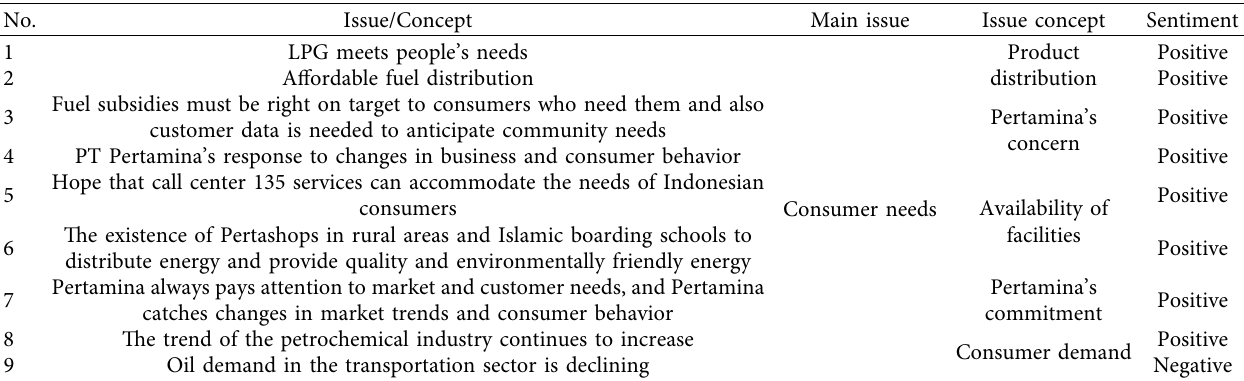
Table 2: Analysis of the concept of